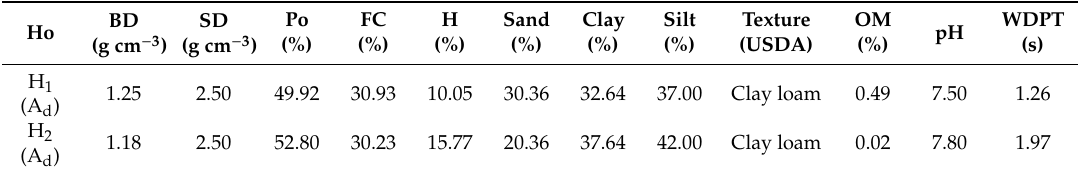
Figure 2. Remediated soil profile. Table 2. Remediated soil horizons characteristics.